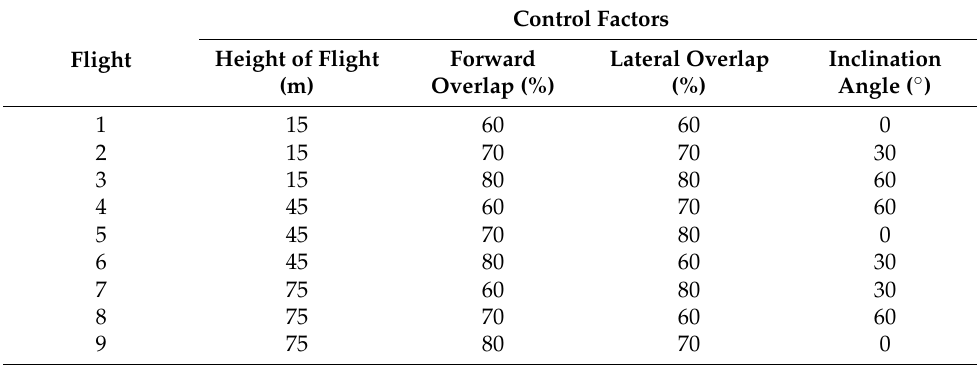
Table 3. Proposal for the application of Taguchi DOE Method to photogrammetric flights.